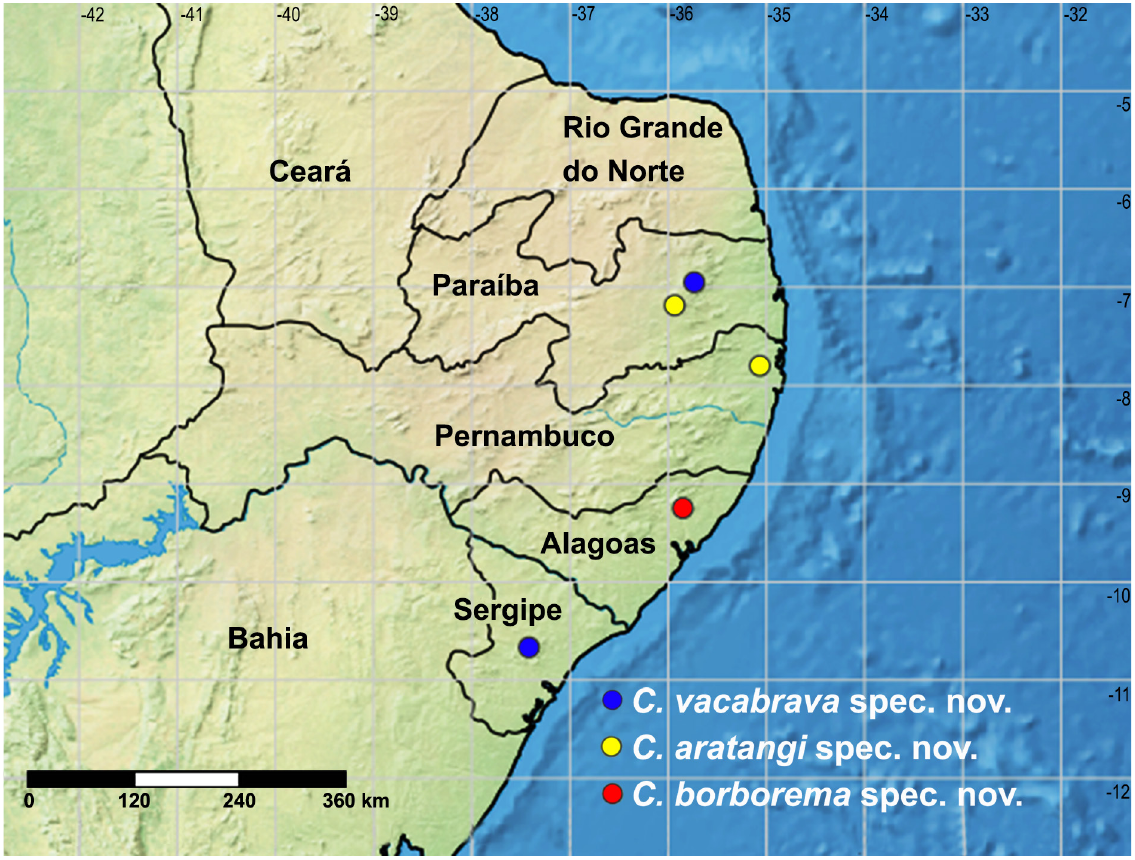
Fig. 11. Distribution map for species of the genus Cuiambuca gen. nov.